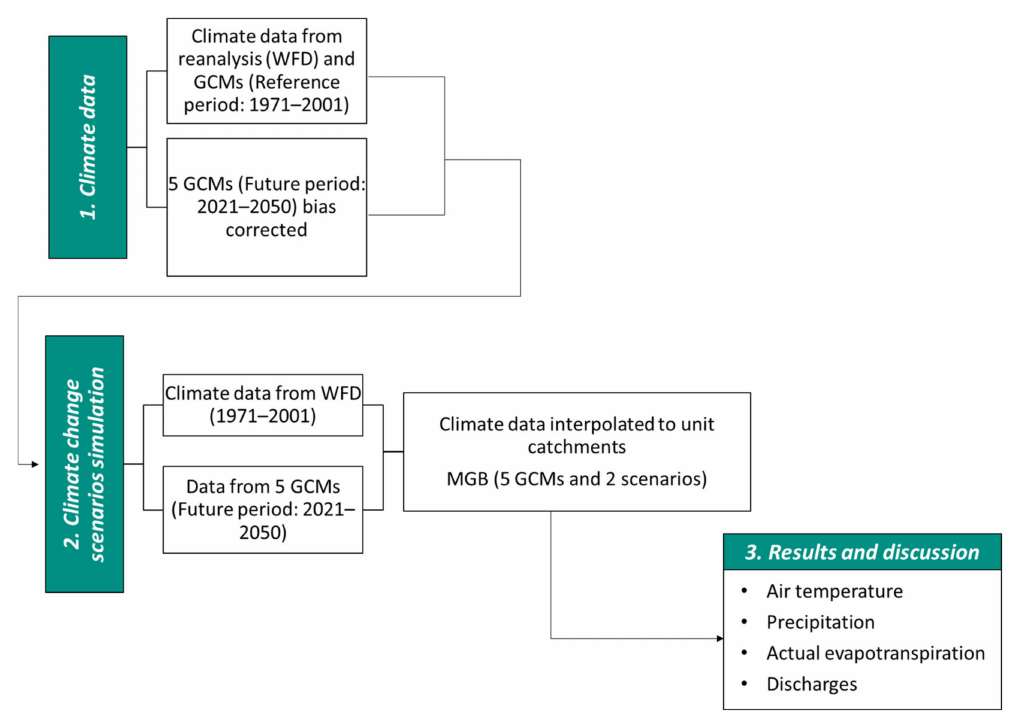
Figure 2. Methodological framework for assessing climate change impacts on the hydrological